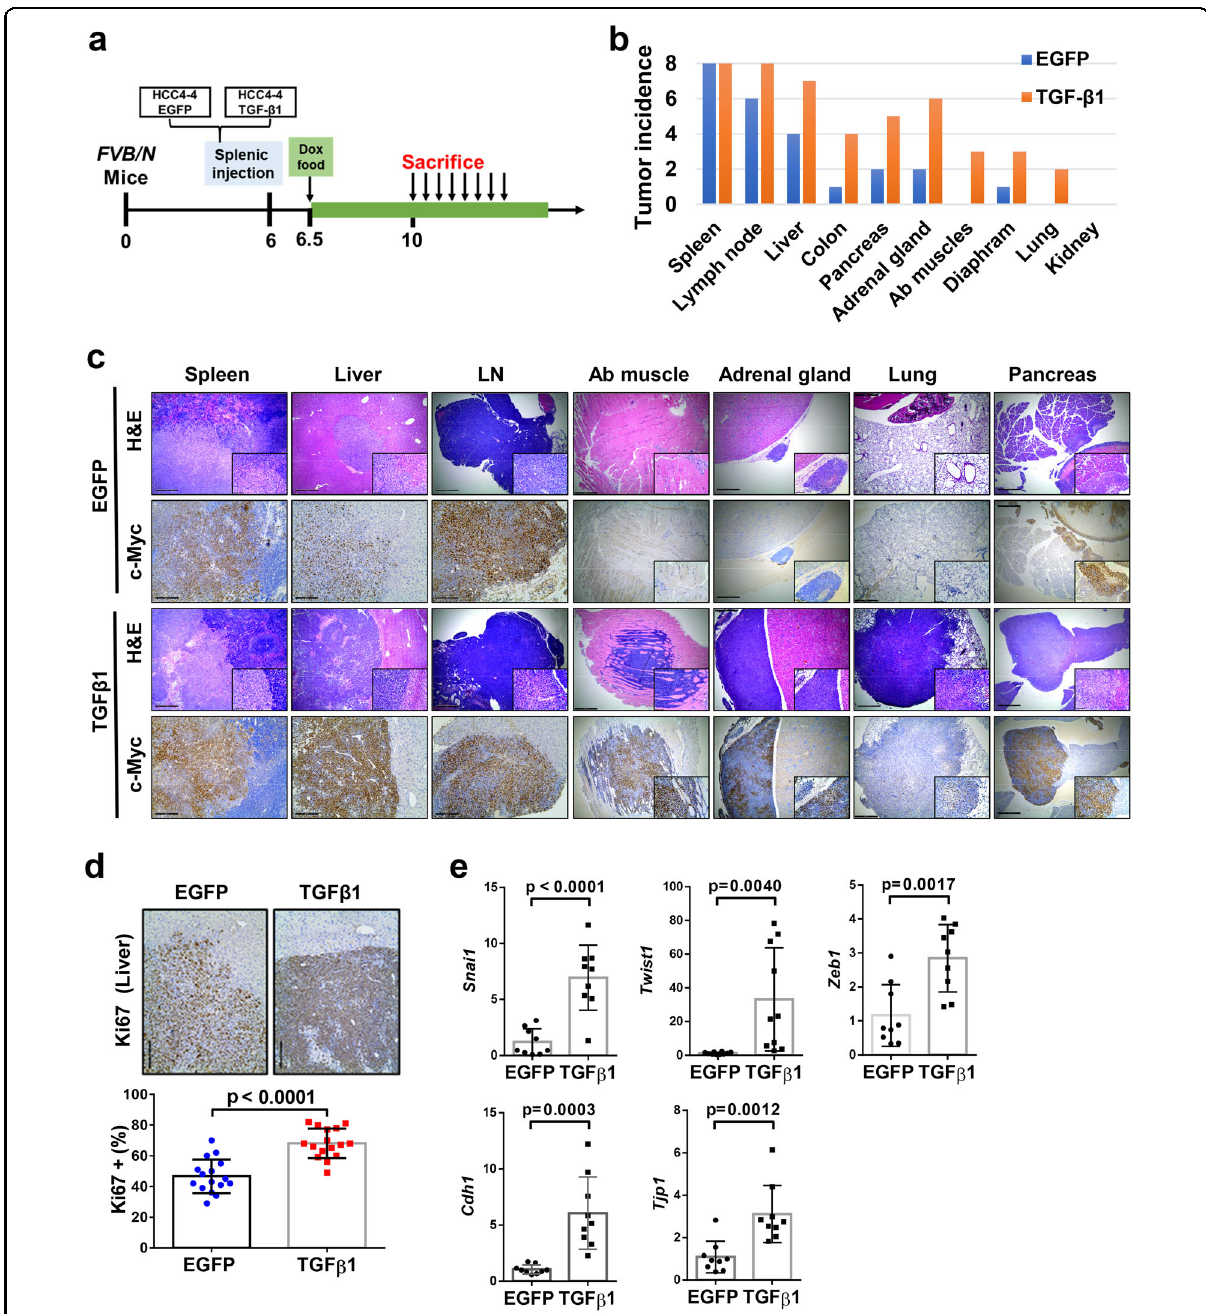
Fig. 5 TGF β 1 activation promotes c-Myc positive tumor cells progression and metastasis in vivo. a Study design. Inducible TGF β 1 (or EGFP) expressing HCC4-4 cells were delivered into mouse liver through intrasplenic injection. Food containing doxycycline (Dox food) was administered 3 days after implantation to induce TGF β 1 or EGFP expression. Three mice from each arm (EGFP or TGF β 1) were sacri fi ced 4 weeks after implantation, and then mice were sacri fi ced every 3 days one per group in parallel. b Numbers of mice showing tumors in each organ at the time of sacri fi ce from EGFP ( N = 8) and TGF β 1 ( N = 8) groups. The Y axis (tumor incidence) represents the number of mice from the EGFP or TGF β 1 group displaying neoplastic lesions in each organ. Tumors were examined macroscopically and microscopically by H&E staining. c Representative images of H&E and c-Myc immunohistochemical staining in EGFP and TGF β 1 groups in different organs. Black boxes on right lower corner denote enlarged views for better visualization. Scale bars: 200 μ m for H&E, 100 μ m for c-Myc. d Representative images of Ki67 immunohistochemical staining and quanti fi cation of Ki67 positive cell percentage in liver tumors from both groups. Student t test was applied for statistical analysis. P < 0.0001. Scale bars: 100 μ m. e mRNA expression of TGF β downstream target genes ( Snai1 Twist1 , and Zeb1 ) and epithelial marker genes ( Cdh1 and Tjp1) in EGFP or TGF β 1 activated murine liver tumors. Student t -test was applied for statistical analysis.